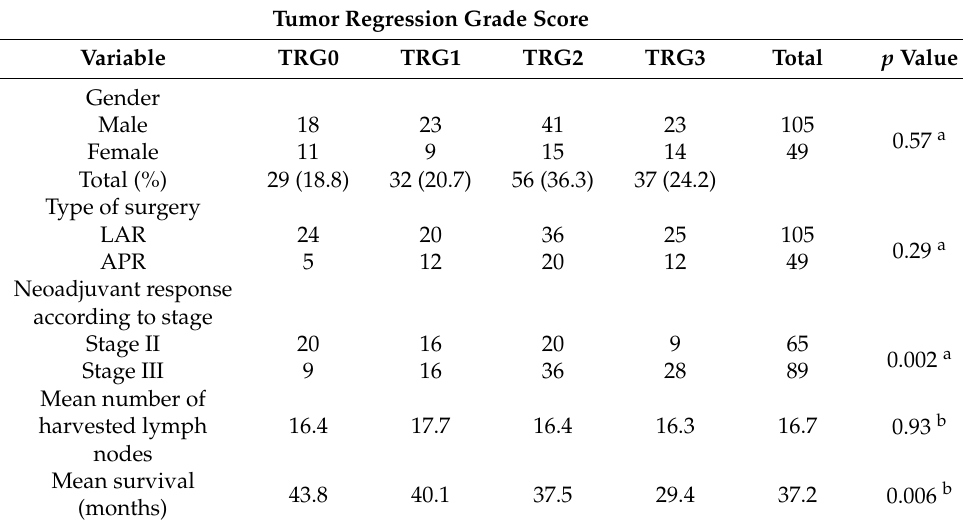
Table 2. Postoperative survival and surgery data according to TRG